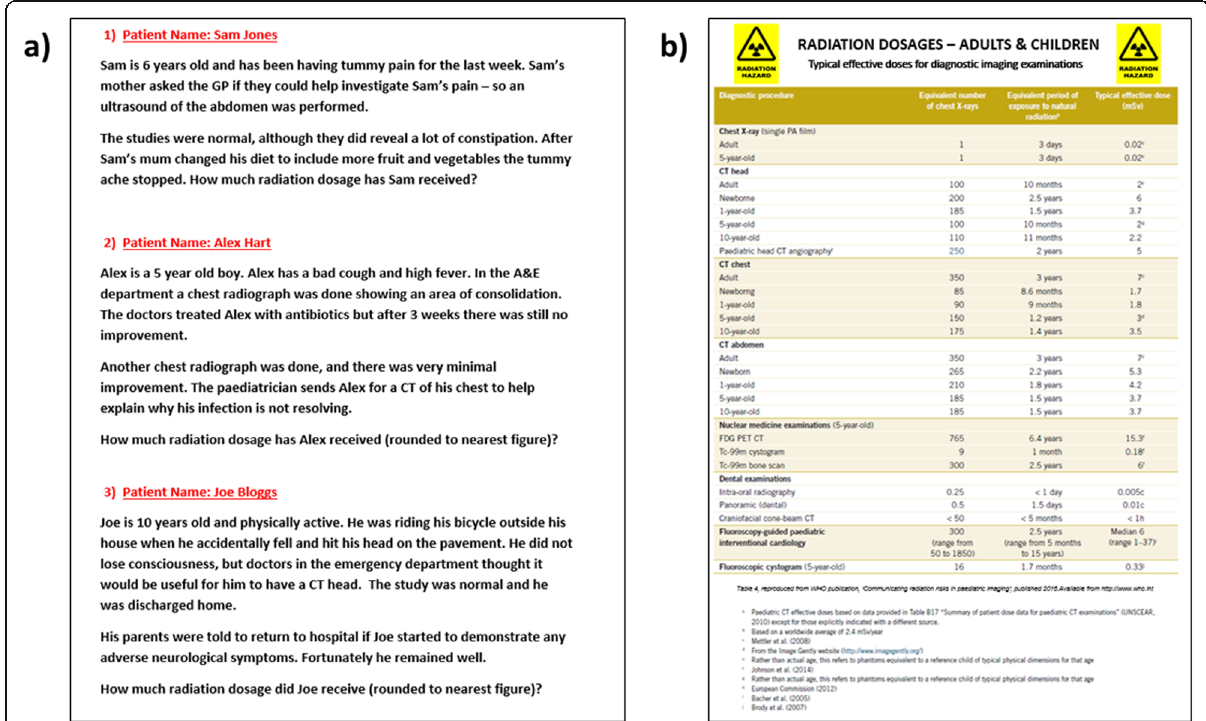
Fig. 4 ‘ Radiation dosages ’ puzzle: In this puzzle ( a ) the patient scenarios are placed on the wall, with a list of ( b ) radiation dosages on another wall, based on the WHO 2016 publication, ‘ Communicating radiation risks in paediatric imaging ’ [27]. Students are required to calculate the radiation dosages from the different radiology modalities and examinations to solve the three-number combination. In this example, the combination code was 0, 3 and